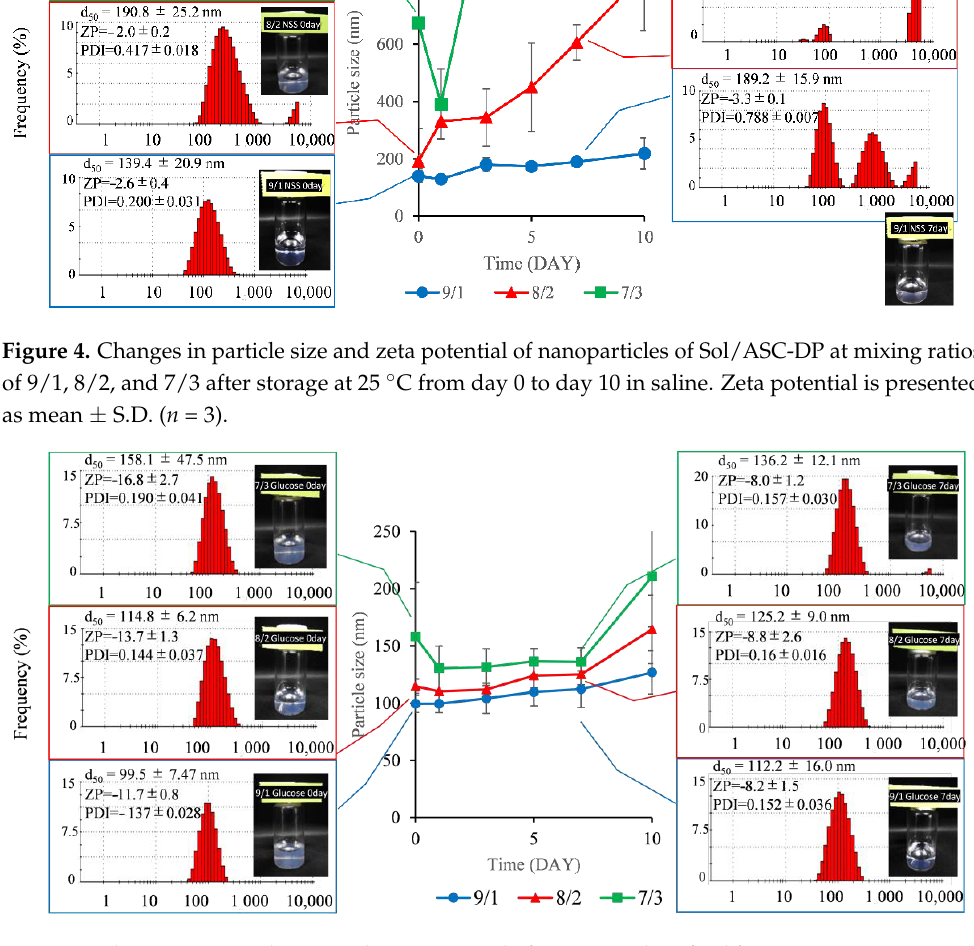
Figure 5. Changes in particle size and zeta potential of nanoparticles of Sol/ASC-DP at mixing ratios of 9/1, 8/2, and 7/3 after storage at 25 °C from day 0 to day 10 in 5% glucose solution. Zeta potential is shown as mean ± S.D. ( n = 3).